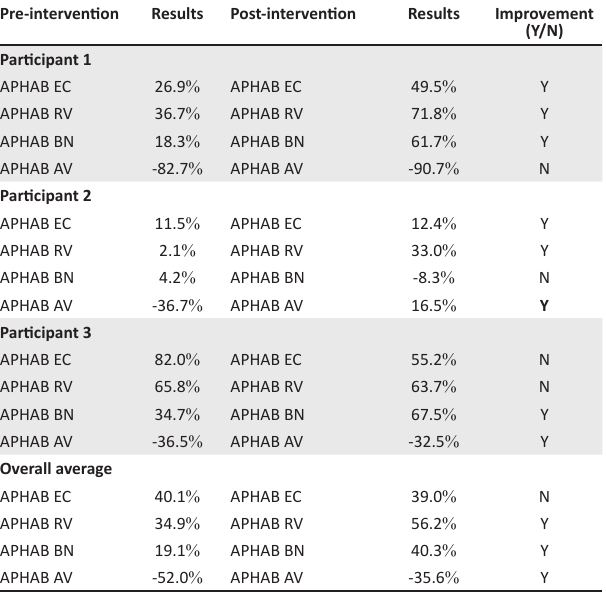
TABLE 5: Abbreviated Profile of Hearing Aid Benefit results. Pre-intervention